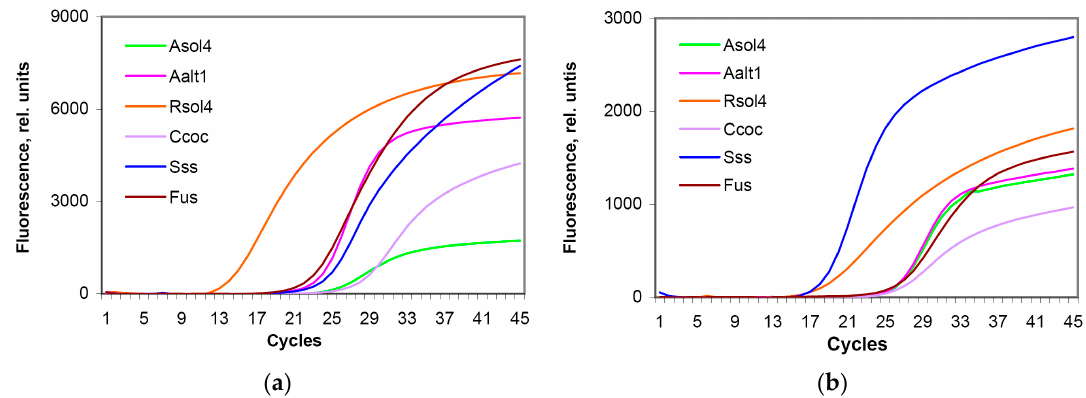
Figure 4. Parallel detection of target potato pathogens using ( a ) freshly prepared and ( b ) lyophilized test systems applied onto 48-well Si microarrays. Test systems designations: Asol4 , Alternaria solani ; Aalt1 , A. alternata ; Rsol4 , Rhizoctonia solani ; Ccoc , Colletotrichum coccodes ; Sss , Spongospora subterranea ; Fus , Fusarium spp.